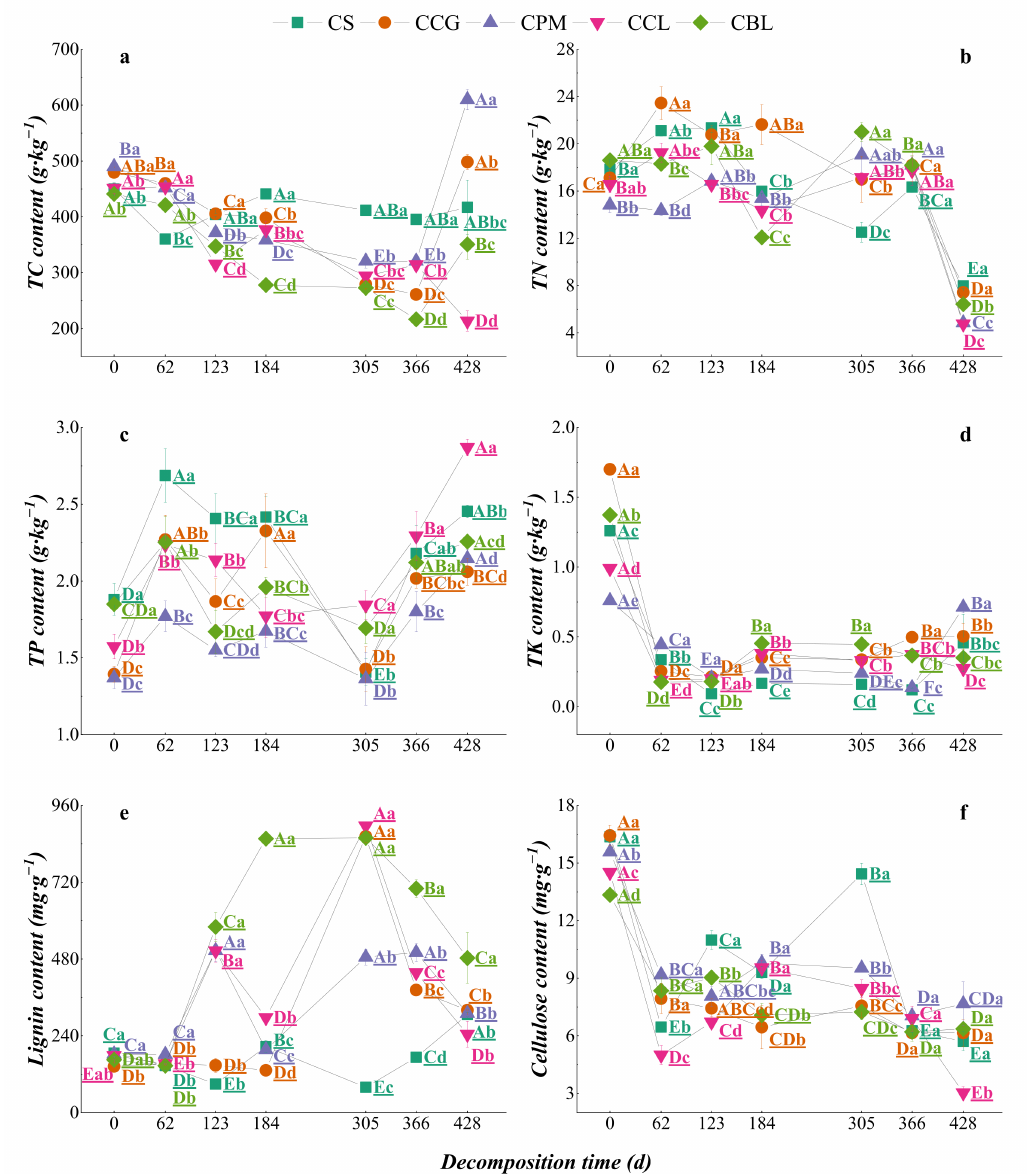
Figure 4. Dynamic changes in nutrients of different plant residues during the decomposition pro- cess. Note: A, B, C—differences between decomposition stages of the same treatment ( p < 0.05); a, b, c—differences between treatments in the same decomposition period ( p < 0.05); ( a )—TC content (g-kg − 1 ); ( b )—TN content (g-kg − 1 ); ( c )—TP content (g-kg − 1 ); ( d )—TK content (g-kg − 1 ); ( e )—Lignin content (mg-kg − 1 ); ( f )—Cellulose content (mg-kg − 1